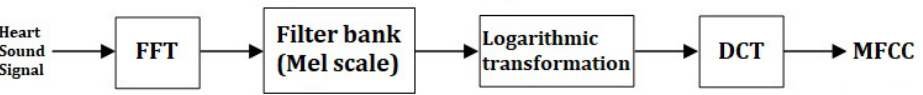
Figure 3. Block diagram for the calculation of the Cepstral Frequency–Mel Coefficients